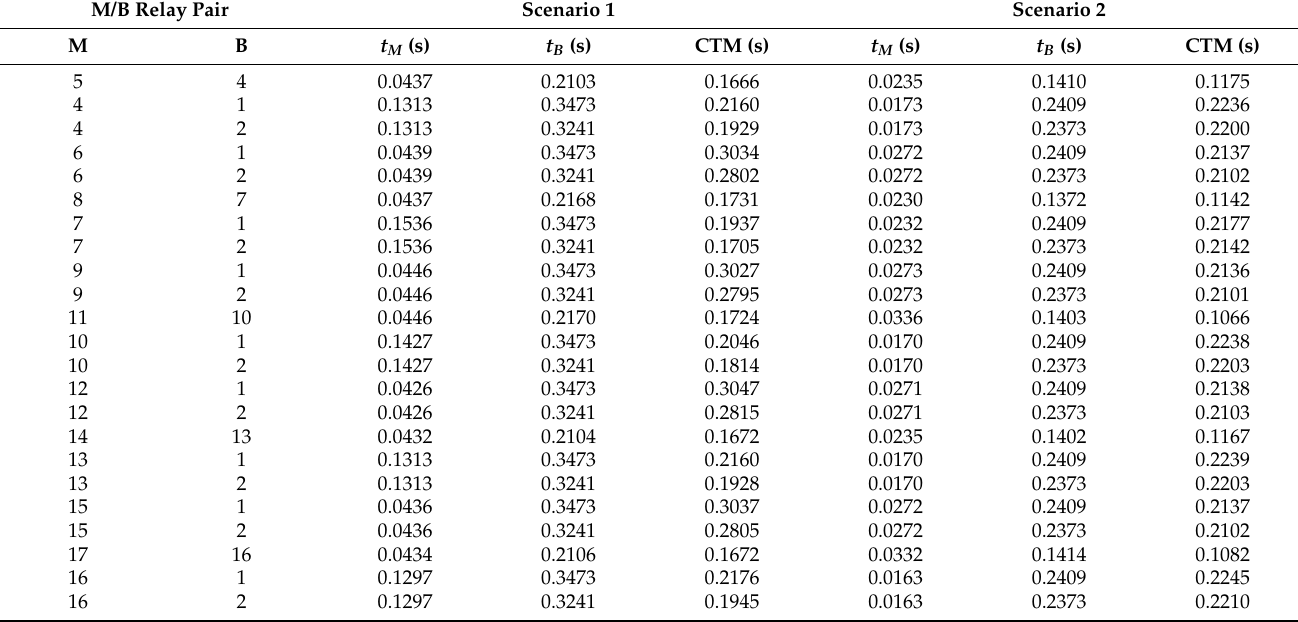
Table 18. Coordination check of Test Model 4.